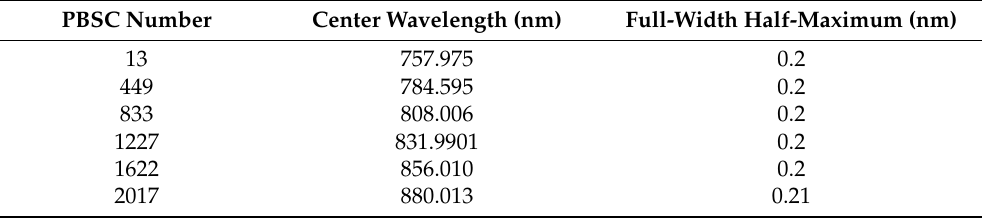
Table 5. Spectral calibration results of water vapor absorption band with observation channel (channel 4).